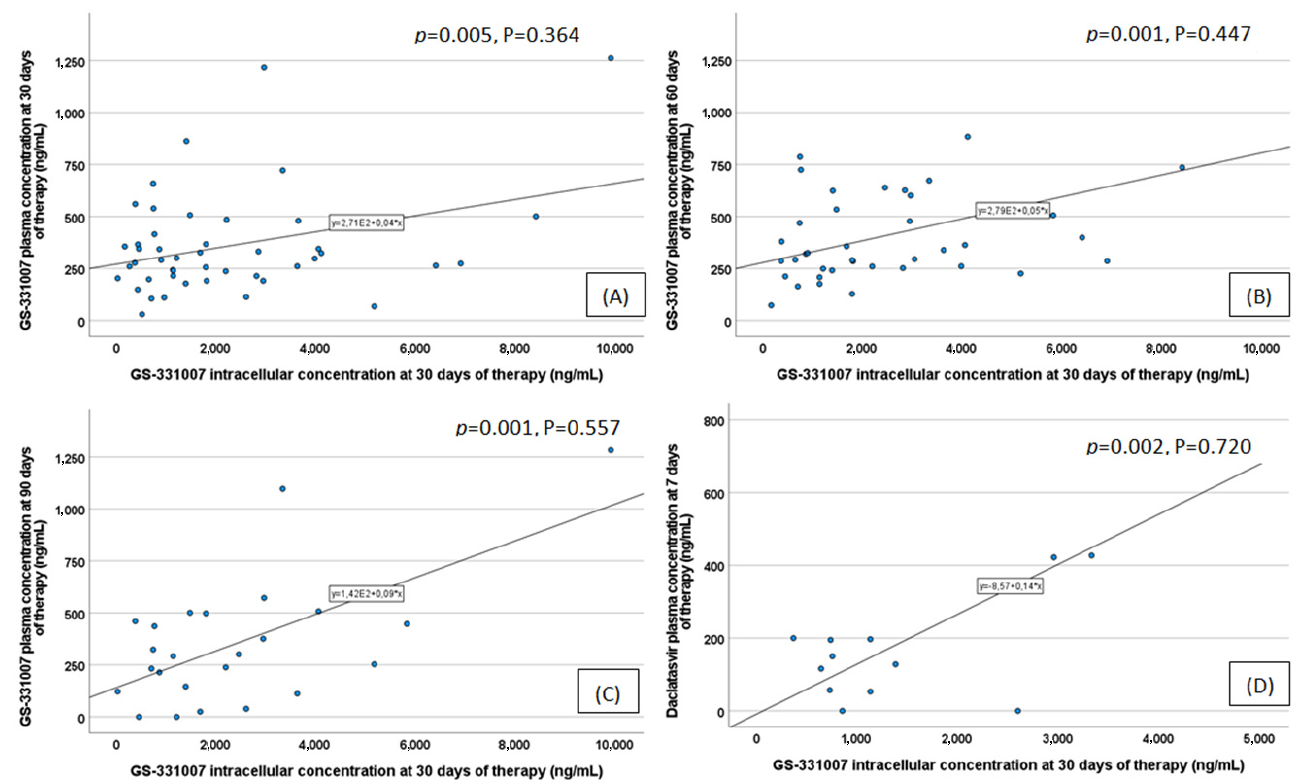
Figure 1. GS-331007 intracellular levels at 30 days of therapy correlated with sofosbuvir plasma concentrations at 30 days ( A ), at 60 days ( B ), at 90 days ( C ) and with daclatasvir (DAC) plasma concentrations at 7 days ( D ). p = p -value, P = Pearson coefficient.